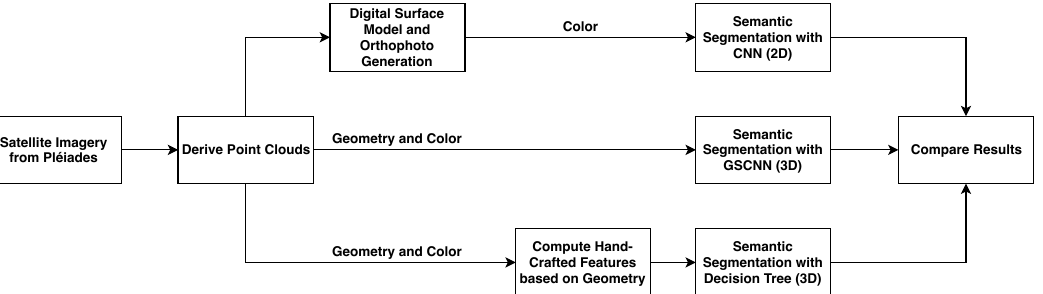
Figure 1. Overview of the general workflow. We use tri-stereo Pléiades images of the study area, Waldviertel. The images are then processed to derive the 3D point cloud and the corresponding orthophoto. Whereas the Convolutional Neural Network (CNN) approach utilizes the orthophoto, the GSCNN semantic segmentation uses the 3D point cloud as input. For the decision tree, we compute hand-crafted geometric features while we leave the color features as they are. Finally, we compare the GSCNN results with the CNN approach and the decision tree, i.e., a strong baseline (Section